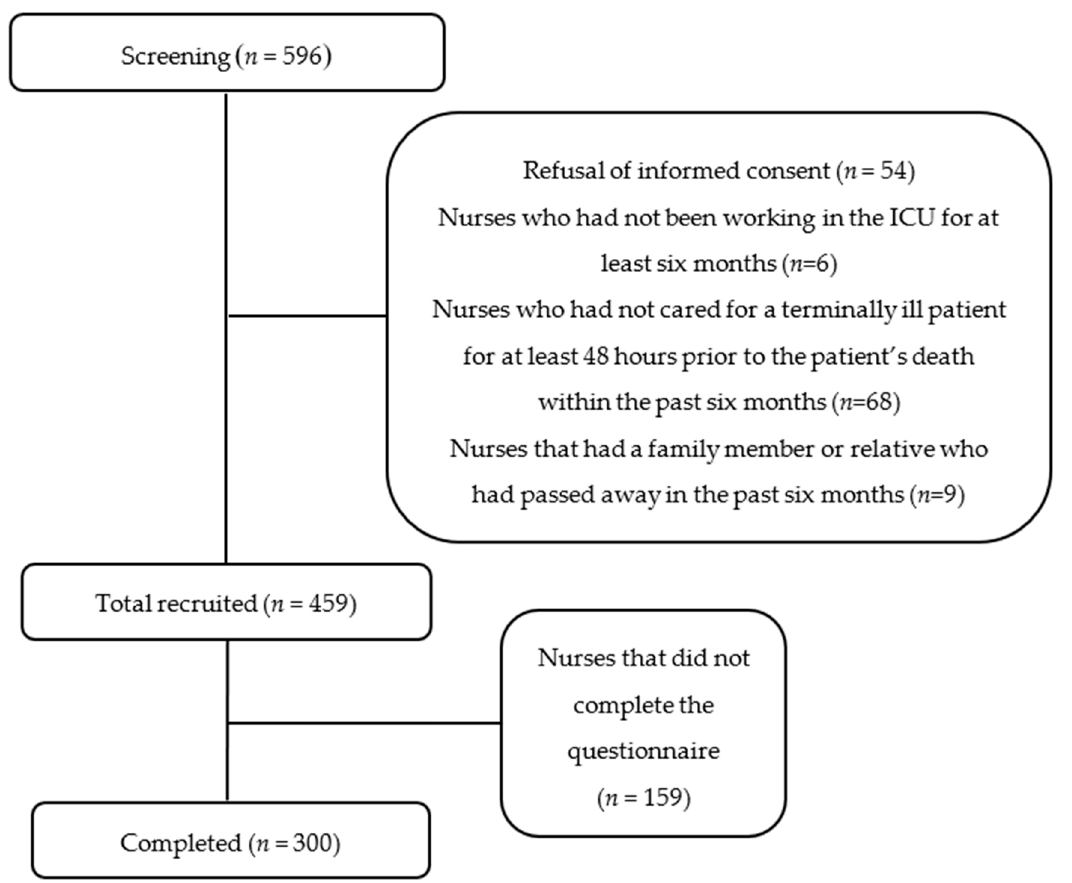
Figure 1. Recruitment flow chart.